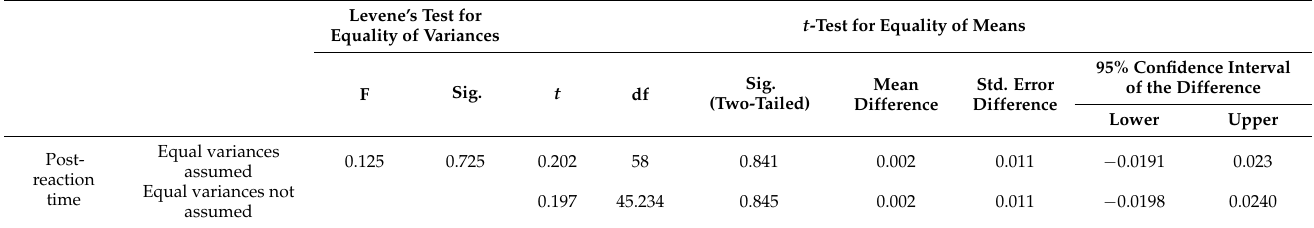
Table 5. Independent samples t -test (gamers and